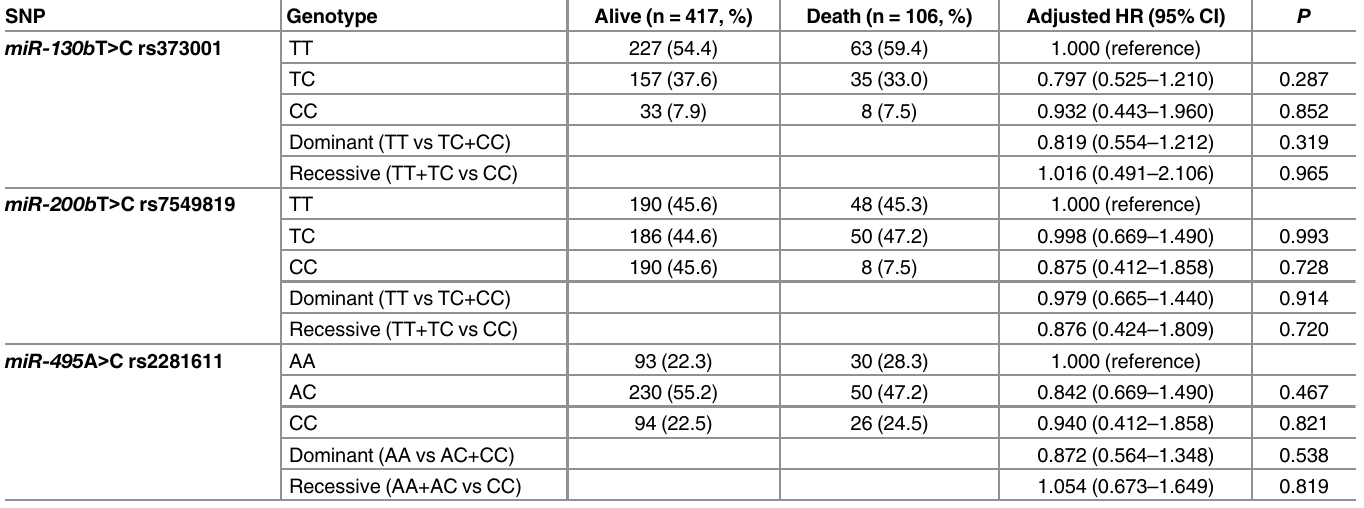
Table 5. Multivariate Cox regression analysis according to miRNA polymorphisms in ischemic stroke patients.